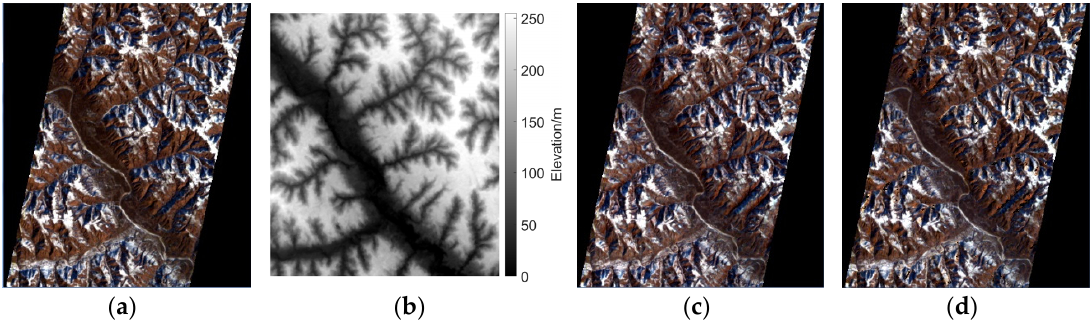
Figure 5. The original data and corrected results: ( a ) RGB hyperspectral image to be corrected; ( b ) digital elevation model (DEM) image; ( c ) RGB radiance image after C correction; ( d ) RGB radiance image after Minnaert correction.